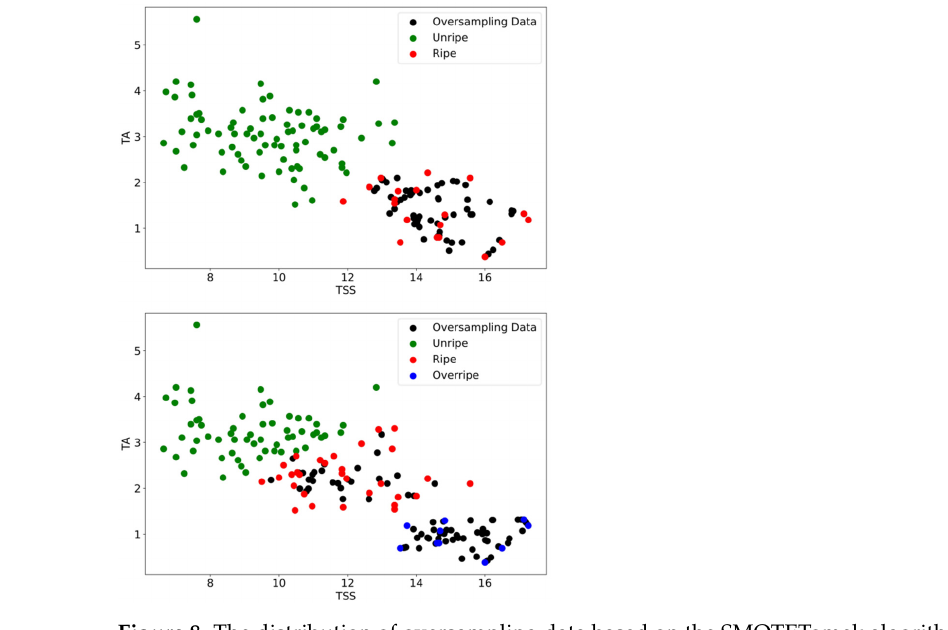
Figure 8. The distribution of oversampling data based on the SMOTETomek algorithm for two ( Top ) and three classes ( Bottom ).